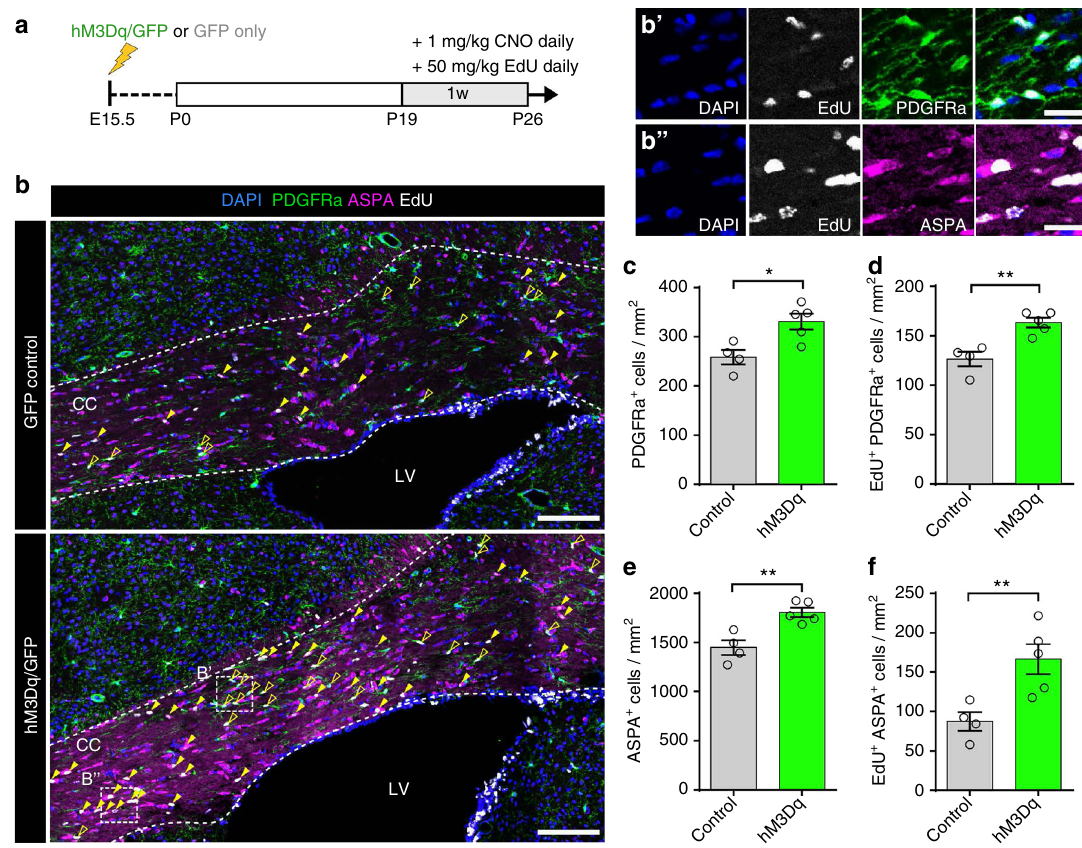
Fig. 2 Activity stimulation enhances oligodendrogenesis in juvenile mice. a Experimental timeline illustrating onset of CNO/EdU administration in juvenile mice that had been electroporated with plasmids containing either hM3Dq and Gfp (hM3Dq) or Gfp only (Control) in utero at E15.5. b Coronal sections through the corpus callosum at P19+7 were immunolabeled with OPC (PDGFRa) and mature oligodendrocyte (ASPA) markers and the number of proliferating (EdU + ) OPCs (open arrowheads, b ’ ) and newly differentiated oligodendrocytes ( fi lled arrowheads, b ” ) was quanti fi ed. c – f Activity stimulation resulted in increased levels of progenitor cell proliferation ( c , d ), as well as enhanced differentiation and oligodendrogliogenesis ( e , f ). Welch ’ s corrected unpaired two-tailed t -test: ** P < 0.01, * P < 0.05; n = 4 Control mice (GFP only), n = 5 hM3Dq/GFP mice, ± s.e.m. Scale bars = 200 µ m ( b ), 20 µ m ( b ’ , b ” ). See also Supplementary Figs. 2,